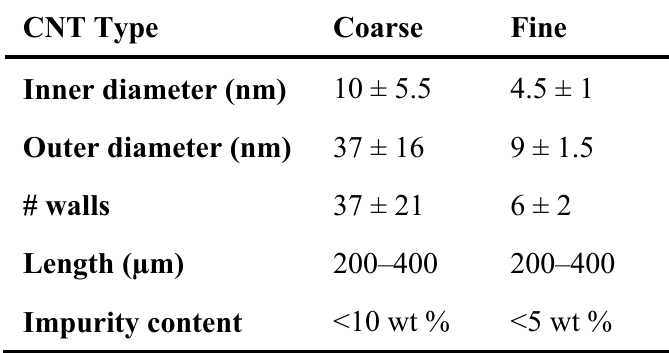
Table 1. Properties of the coarse and fine carbon nanotubes (CNTs) grown by